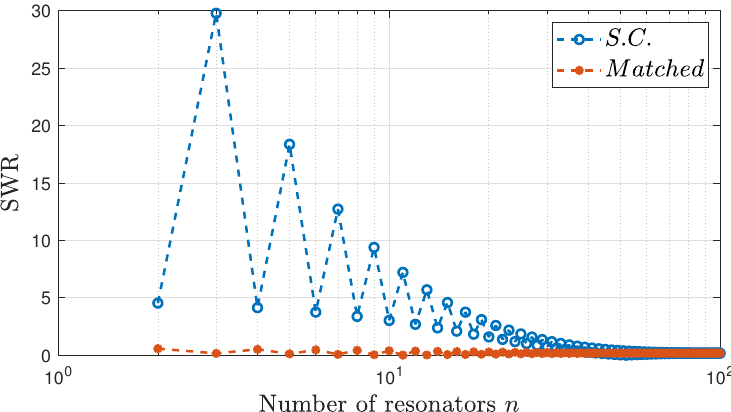
Figure 5. Standing wave ratio for arrays of different length and different termination